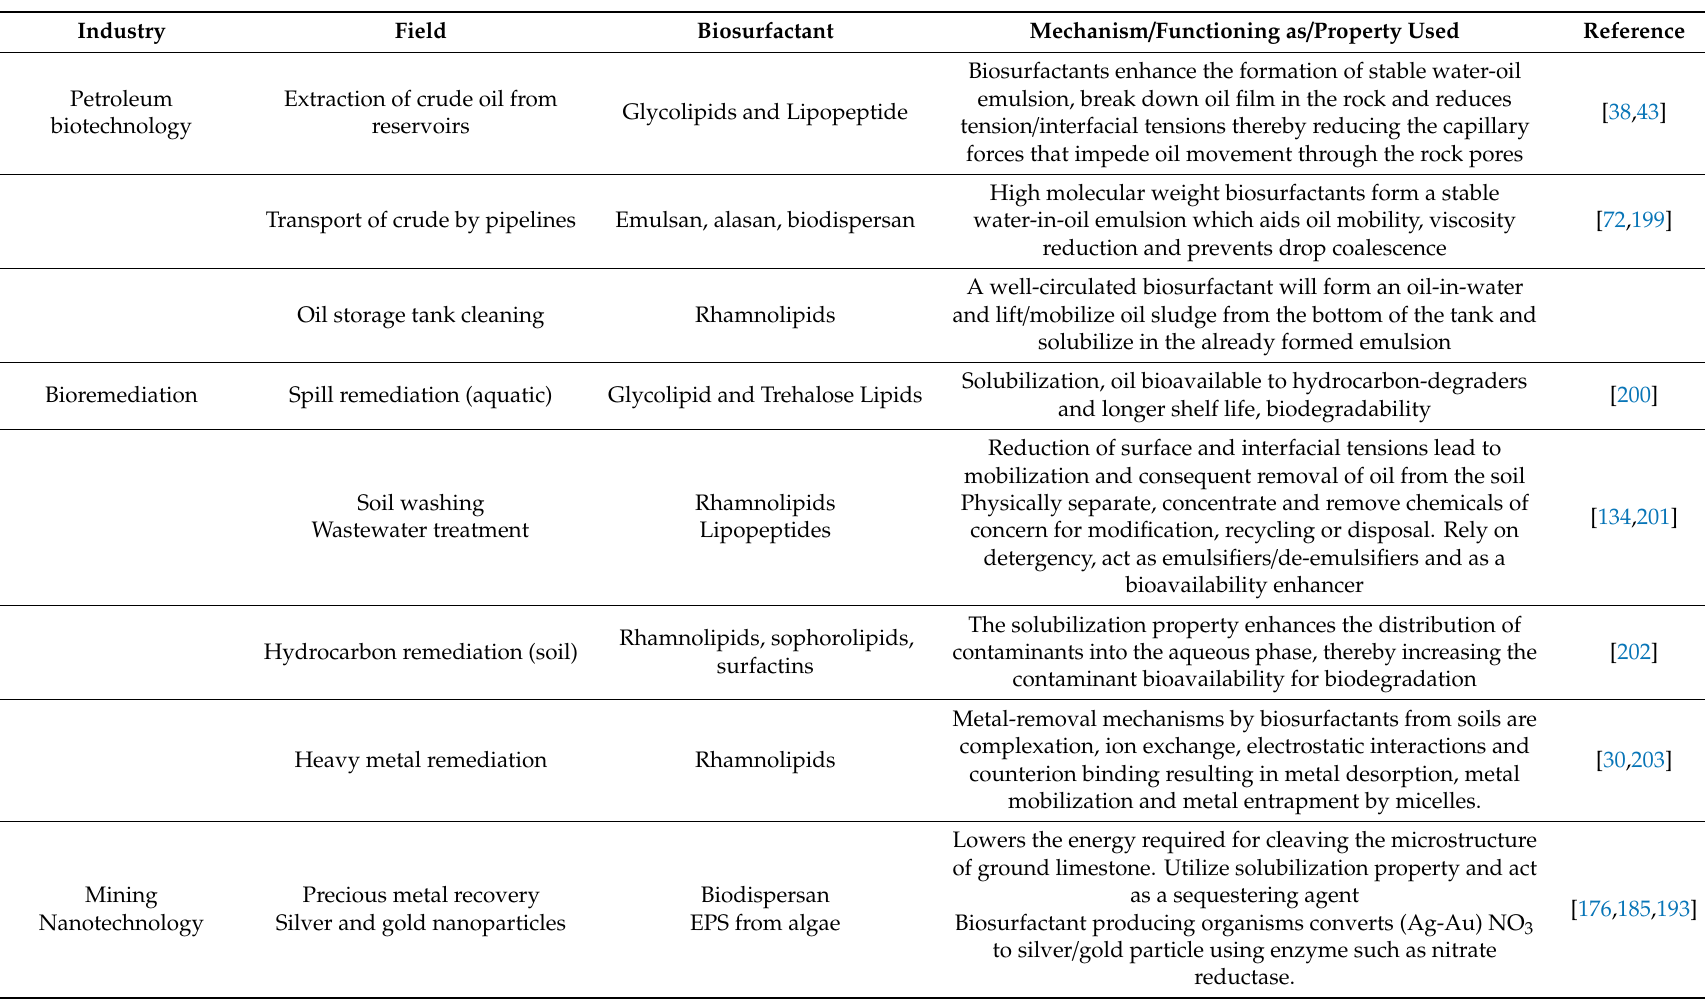
Table 1. Industries where biosurfactants are applied: Medicine / pharmaceuticals, petroleum industry, agriculture, cosmetics, and laundry detergents.